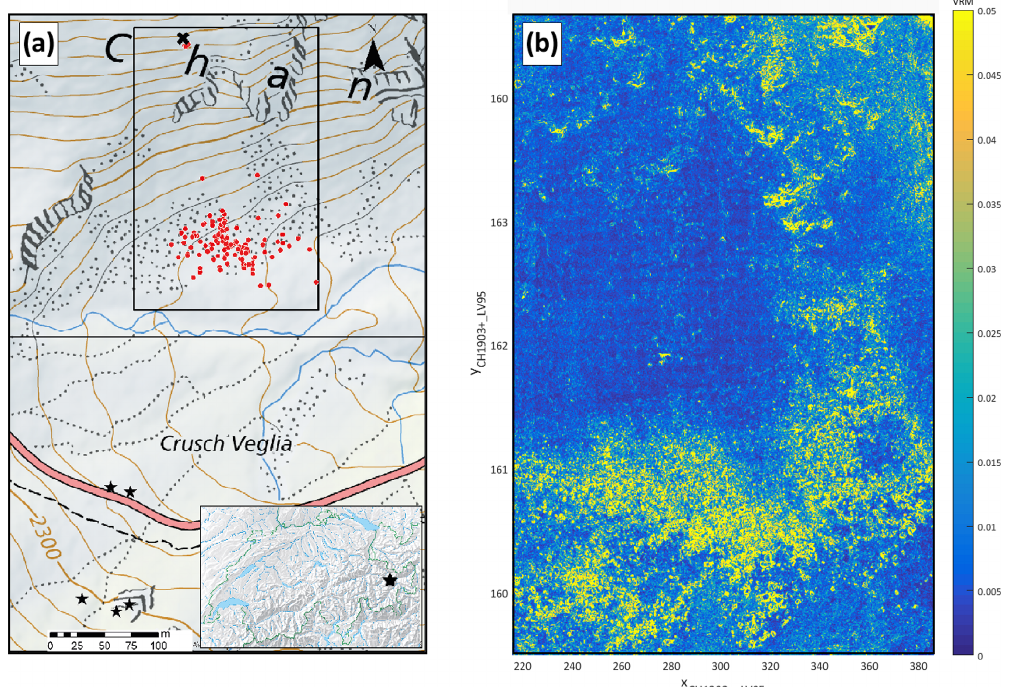
Figure 1. (a) Test site overview: indicated is the release point (black cross) and the full deposition data set comprising 125 deposition points (red dots). The camera positions used for the two RED EPIC video cameras are indicated as black stars. Inset: geographical location of the Chant Sura test site within Switzerland. (b) Surface ruggedness – a vector roughness measure (VRM) – for the extent indicated in (a) determined via the surface normal dispersion, highlighting the high ruggedness in the scree field run-out (Sappington et al.,